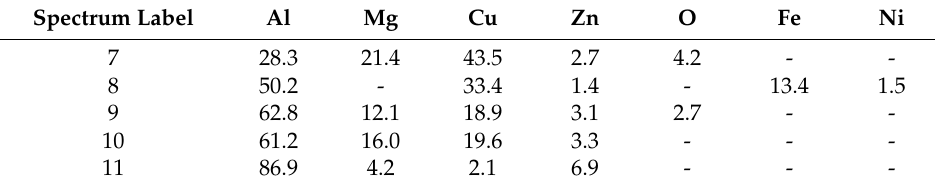
Table 5. SEM-FEG EDS chemical analysis results (% wt).